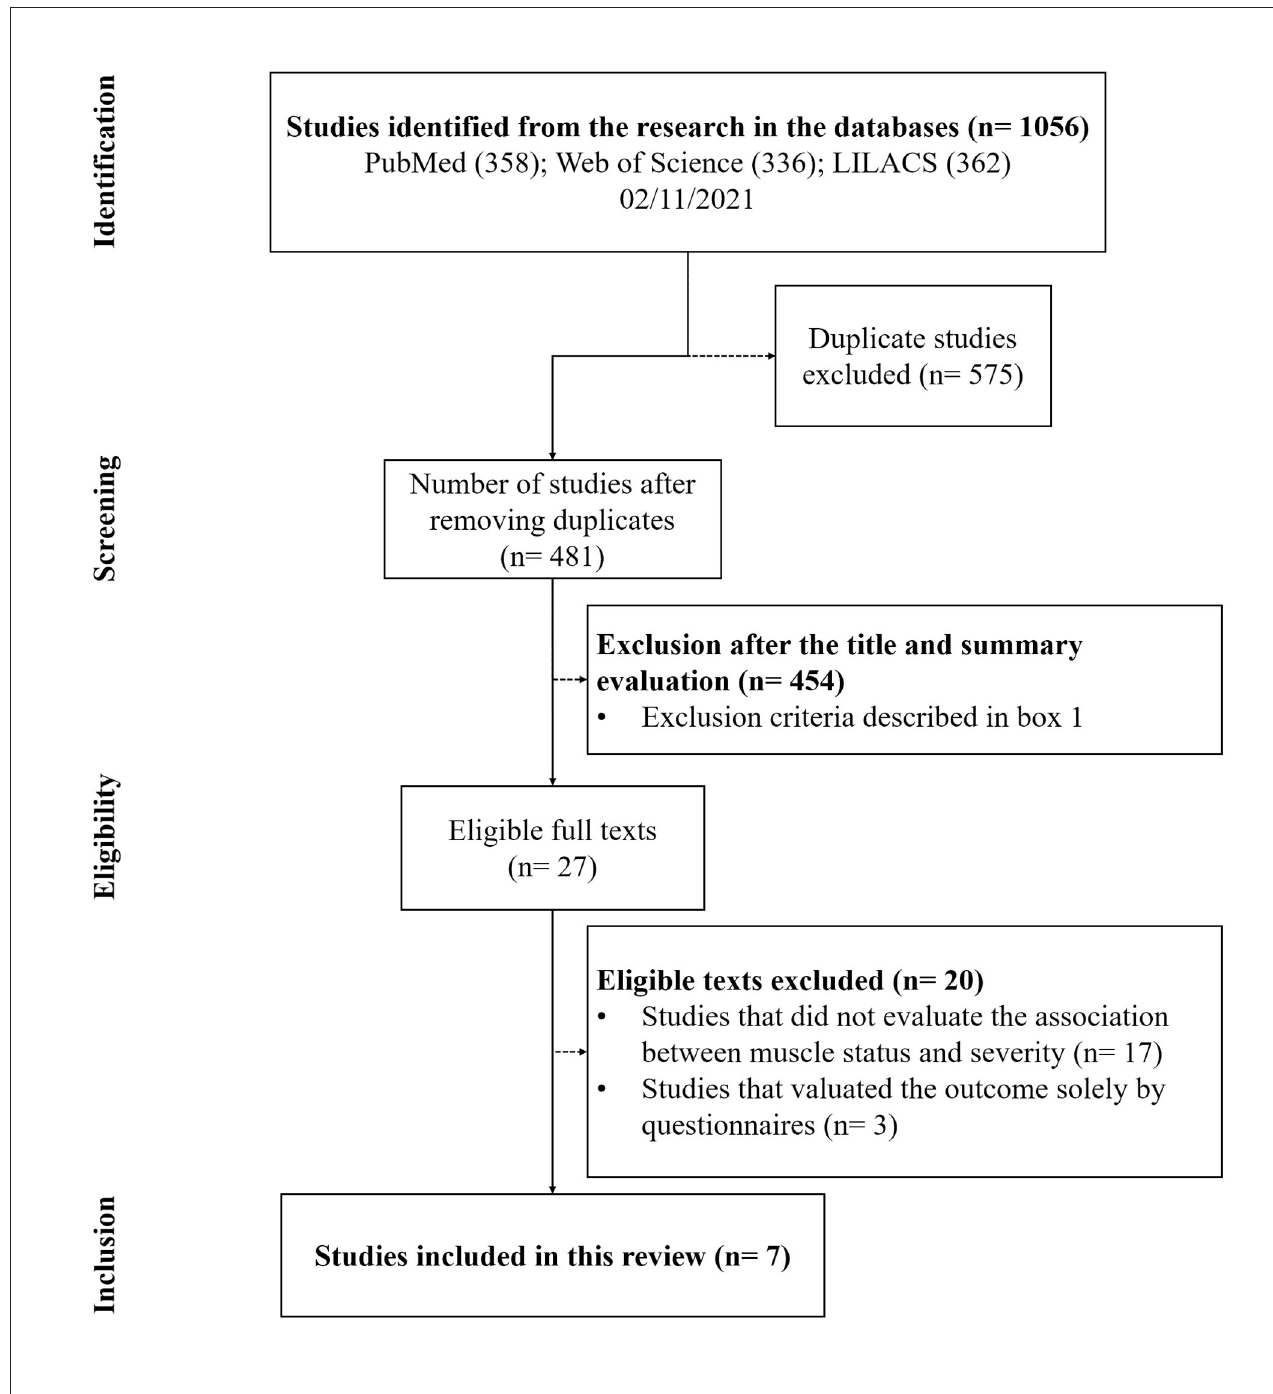
FIGURE 1 | The PRISMA flowchart of systematic